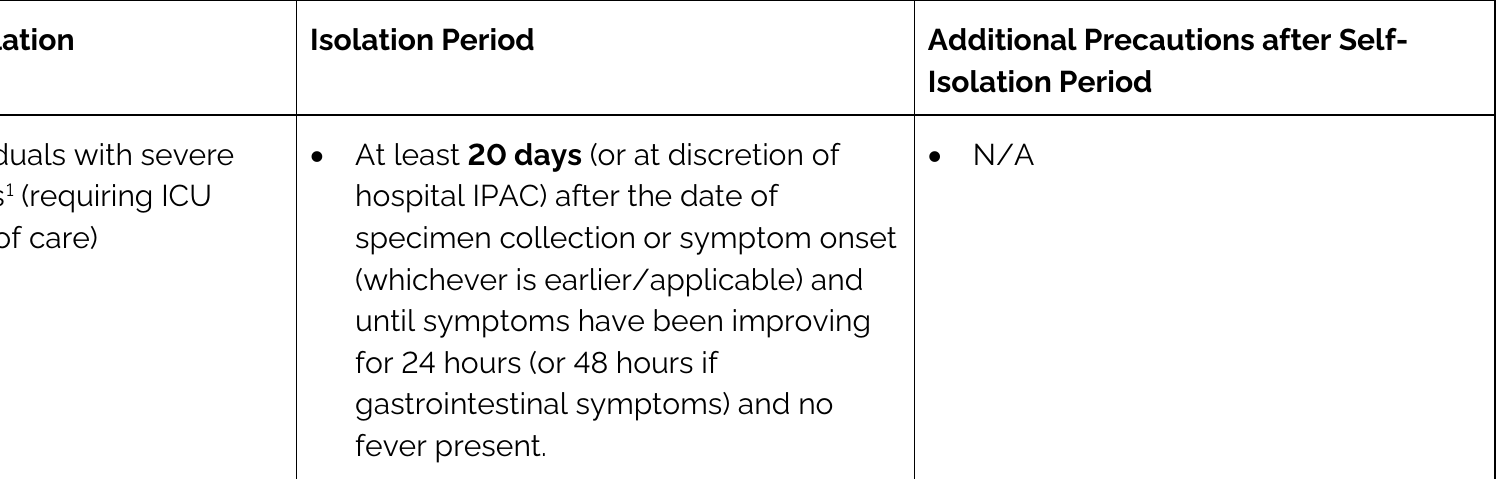
Table 1: Isolation Period for Test-Positive Cases and Individuals with COVID-19